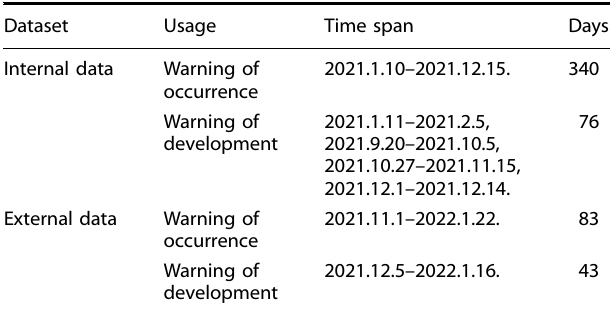
Table 6. Time span of each dataset for each